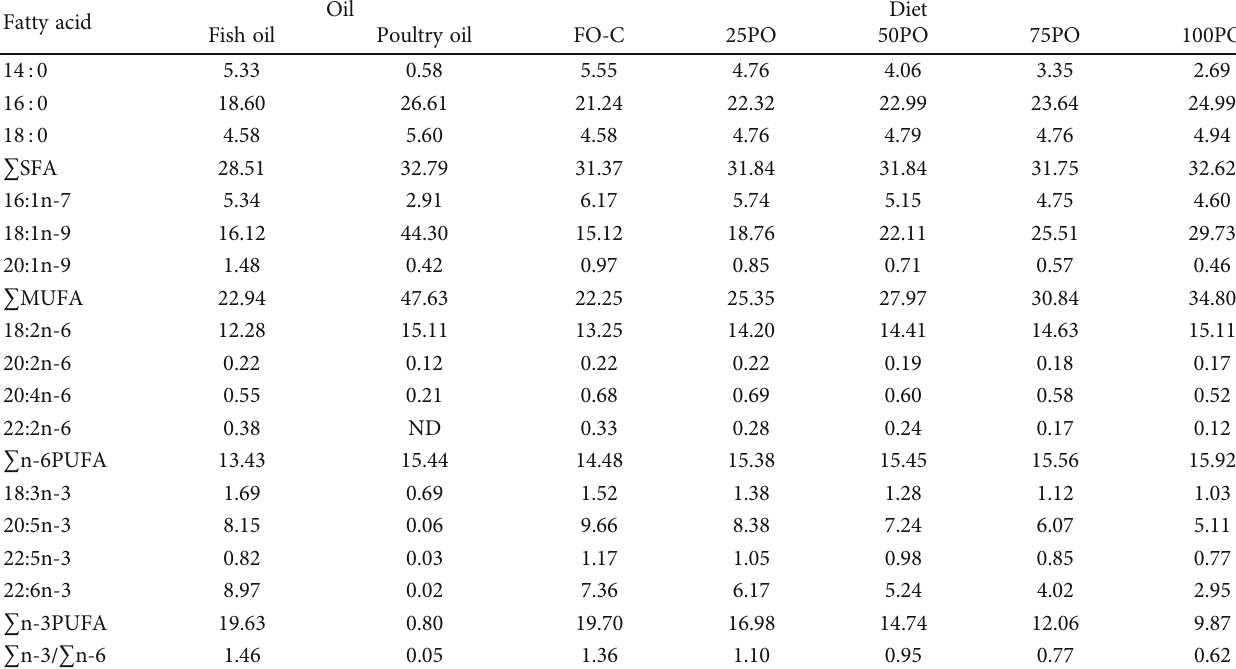
Table 2: Fatty acid composition of fi sh oil, poultry oil, and experimental diets (%TFA). Oil Diet Fatty acid Fish oil Poultry oil